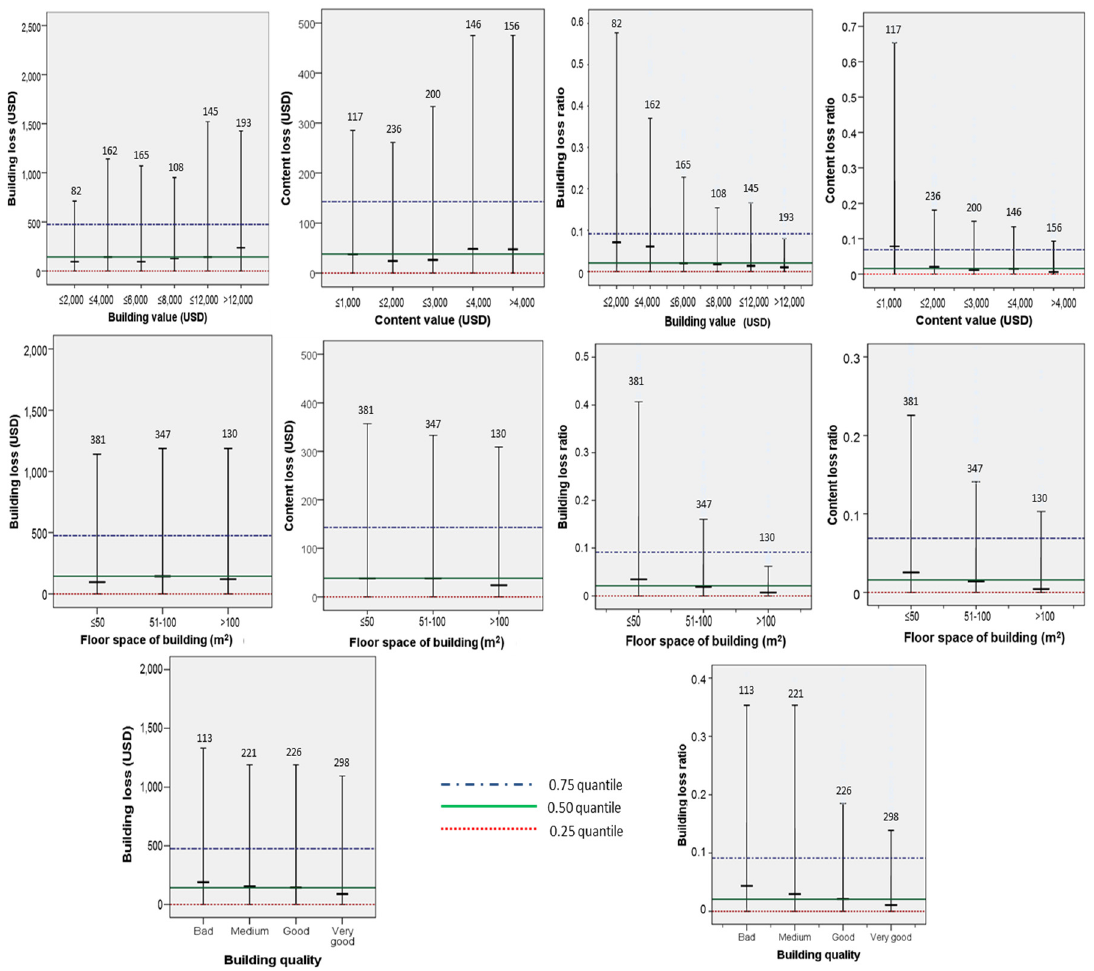
Figure 5. The relation between the building loss ratio and the content loss ration with building/content value, floor space of the building and building quality.